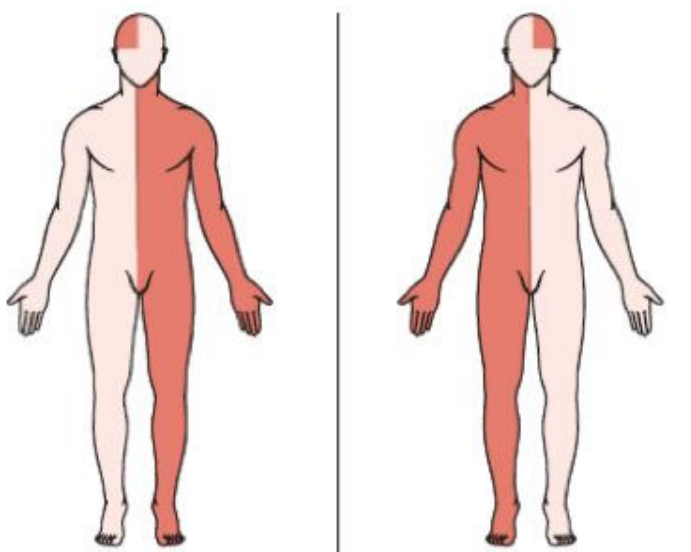
Figure 1. Hemiplegia types. The left picture depicts brain damage in the left part of the brain (all the affected body parts are marked with red color), which causes paralysis to the right part of the body. The right picture depicts brain damage in the right part of the brain, which causes paralysis to the right part of the body.